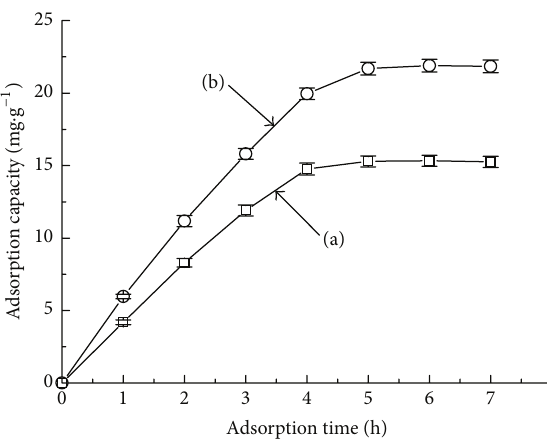
Figure 8: Adsorption curve of L-asparagine on